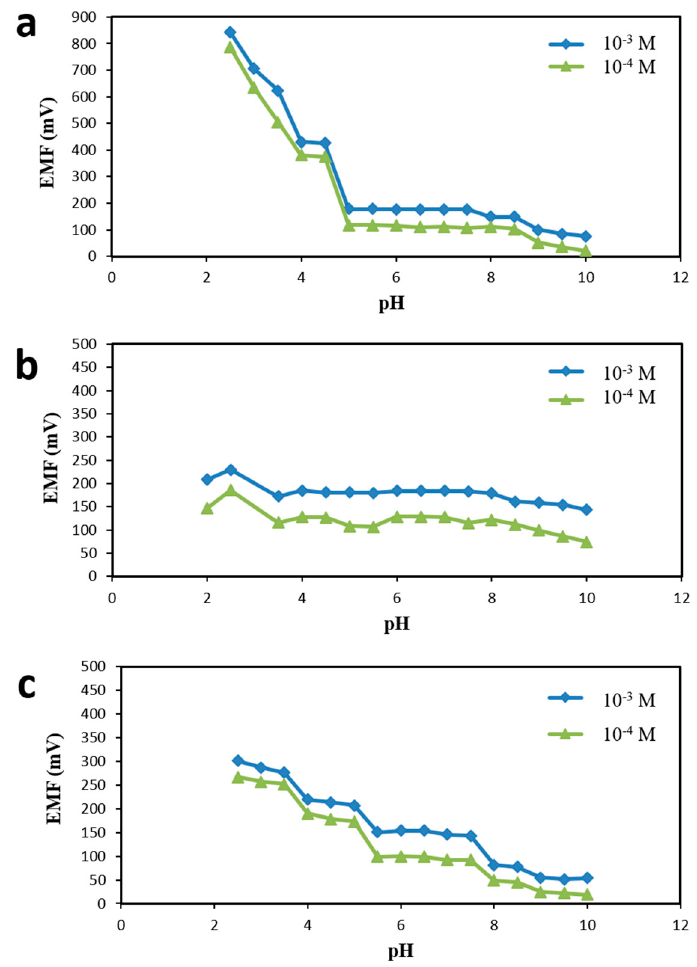
Figure 3. Effect of pH on the response for the proposed ( a ) Bare-Carbon paste electrode, ( b ) AgNp-modified Carbon paste electrode, and ( c ) C-dots-modified Carbon paste electrode using 1 × 10 − 3 and 1 × 10 − 4 M TOBRA concentration.